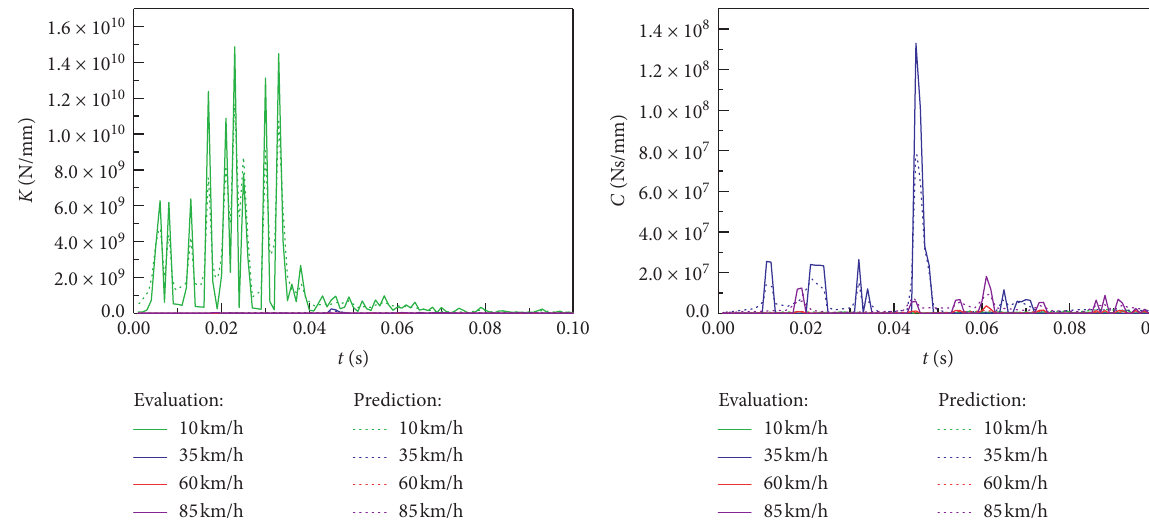
Figure 9: Coupler buffer device 3 comparisons of estimation and prediction.